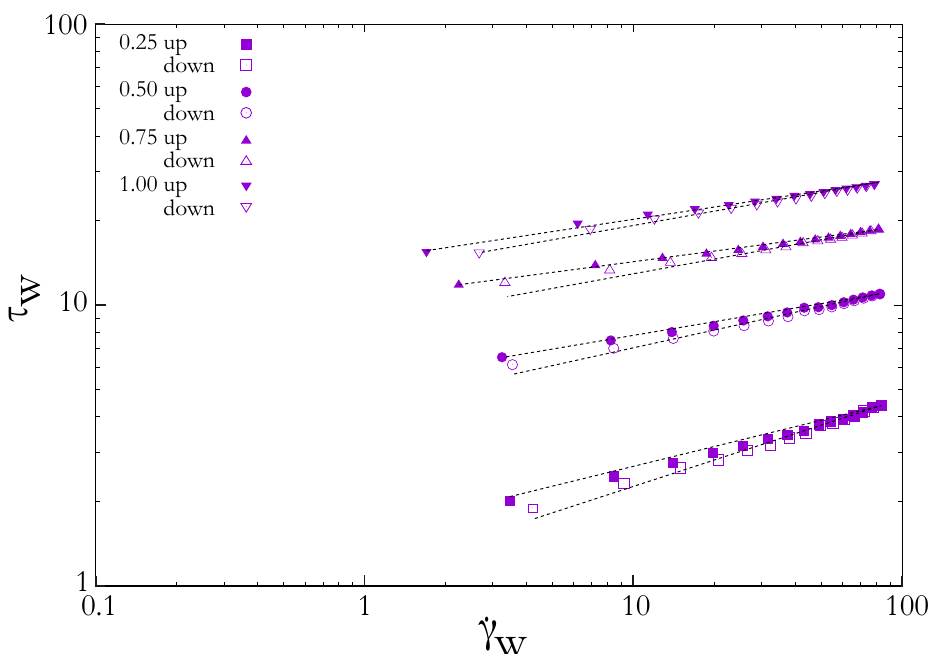
Figure 6. Classical flow curve determined from measurement data ∆ p ( ˙ V ) for xanthan gum aqueous solutions. The fluid shear time under the conditions of the fixed value of ˙ γ was 5 min and the measurement temperature was 21